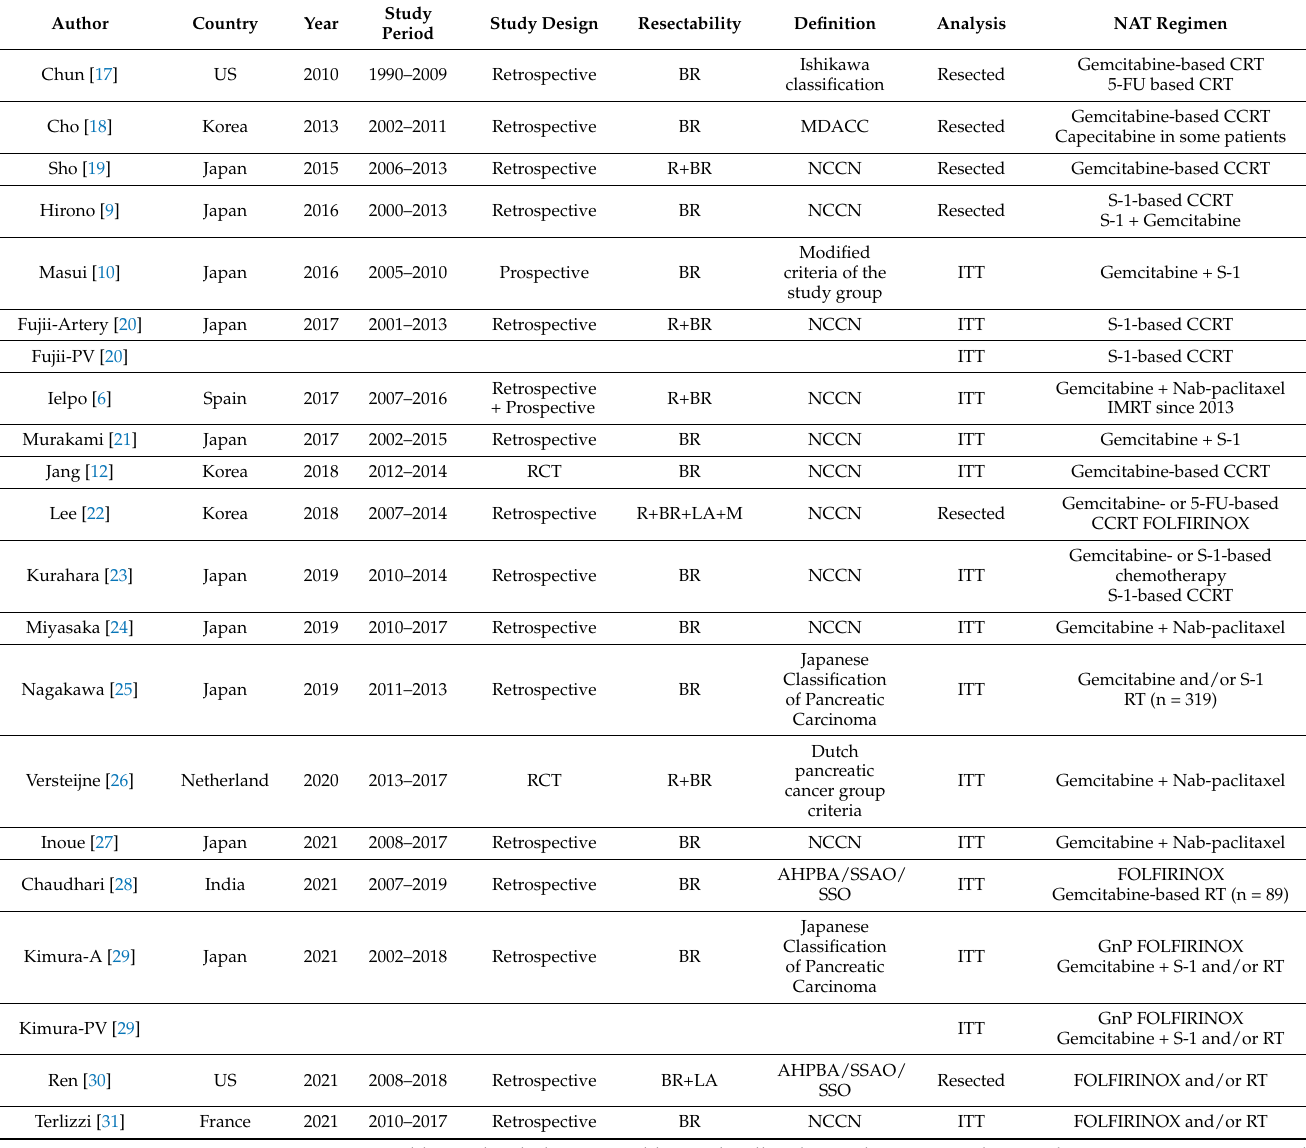
Table 1. General characteristics of included